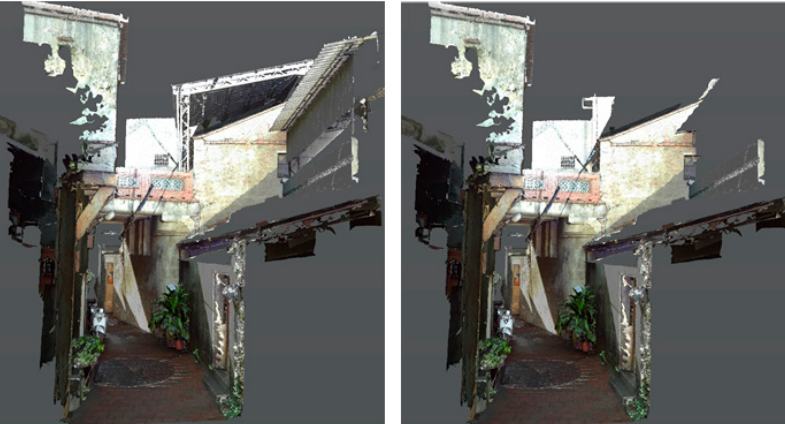
Figure 5. Superimpositions of section annotations (in red line) for an alley in Lukang.